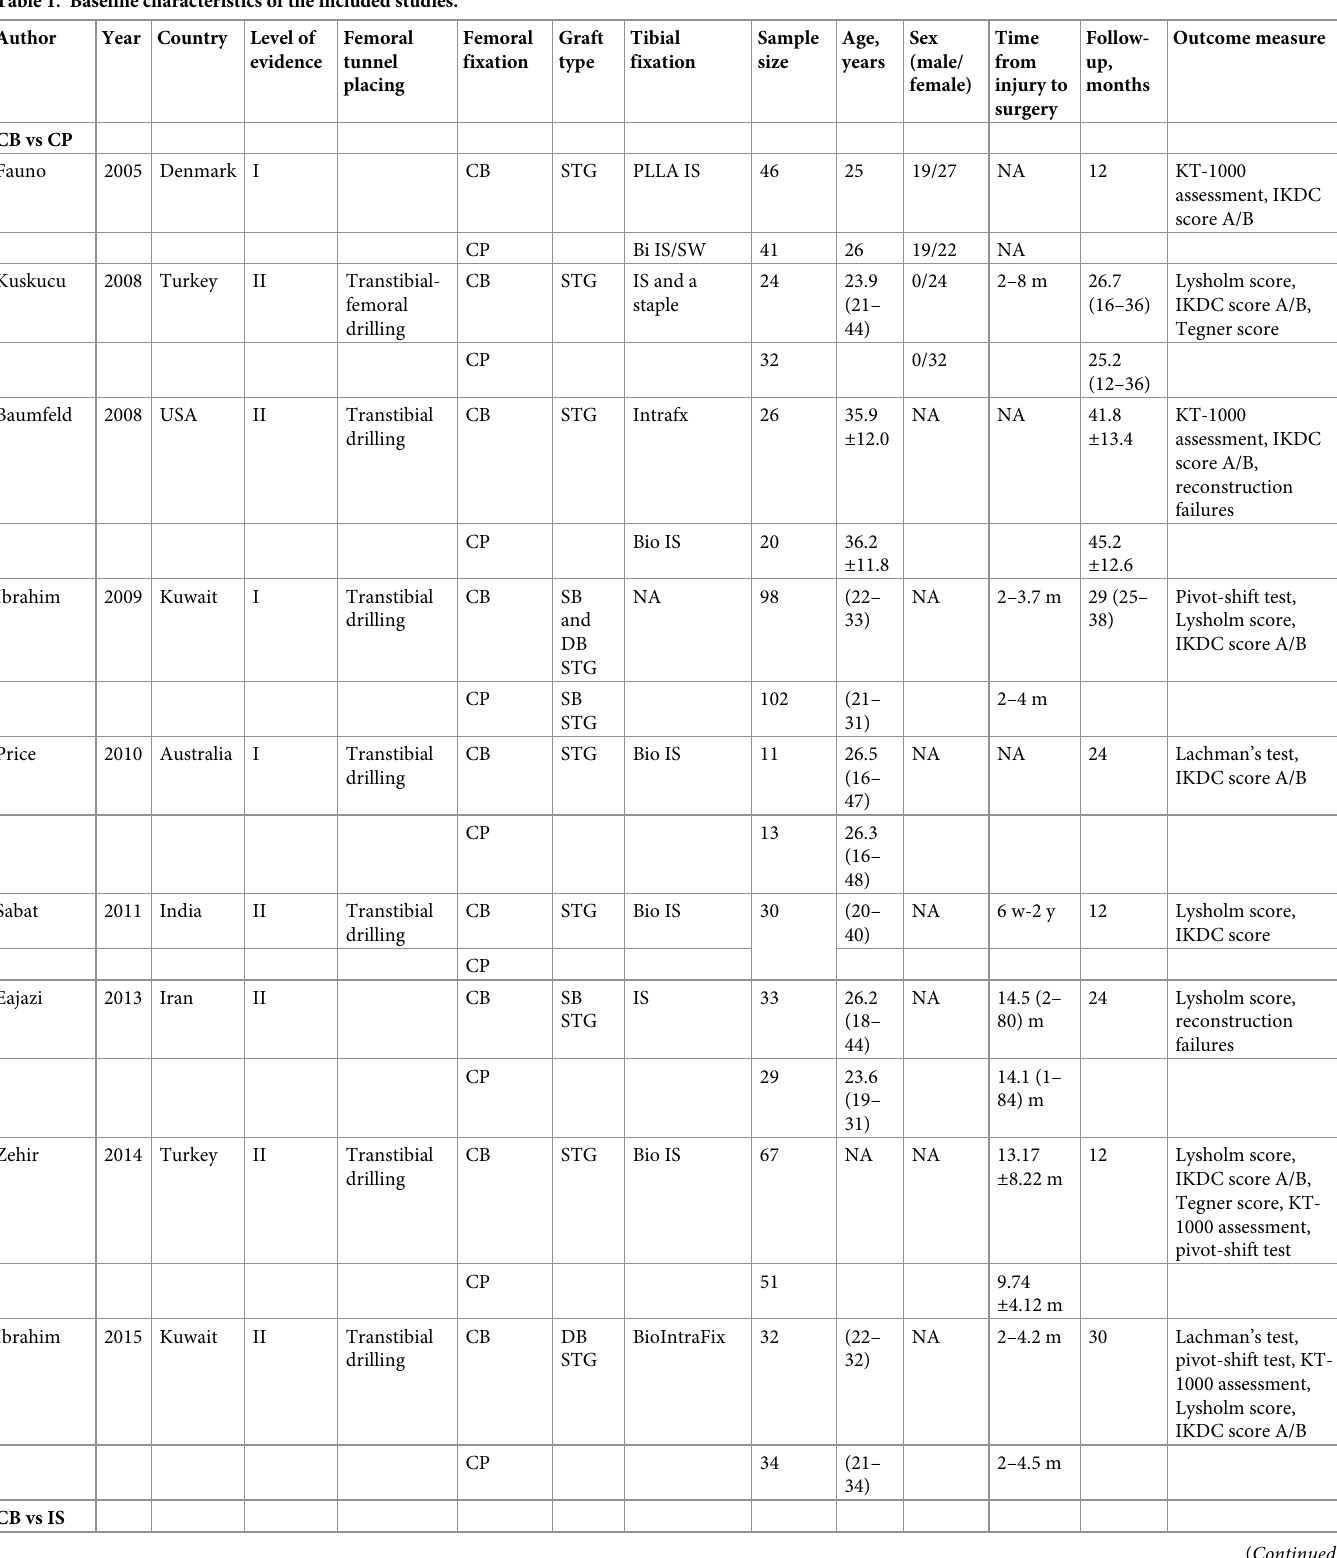
Table 1. Baseline characteristics of the included